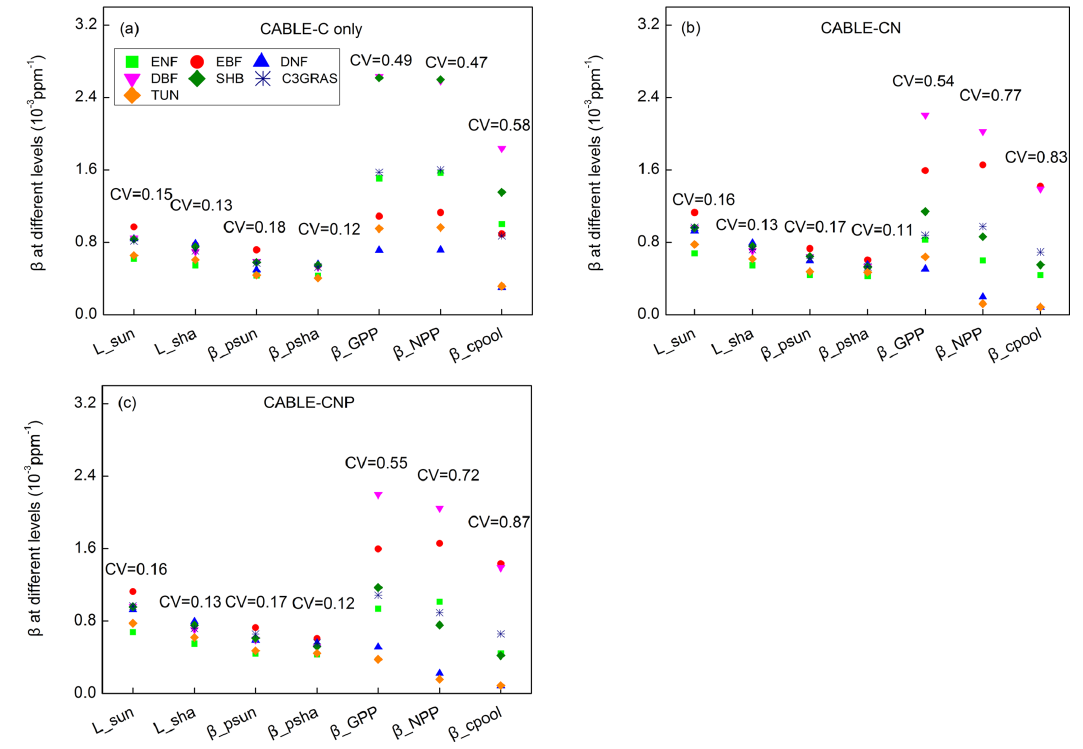
Figure 3. Biome-level β values at different levels at the year 2023 from CABLE-C-only (a) , CABLE-CN (b) , and CABLE-CNP (c) simu- lations. CV means coefficient of variation of biome-level β across C 3 PFTs. β values at biochemical ( L sun and L sha for sunlit and shaded leaves, respectively) and leaf levels ( β p and β p for sunlit and shaded leaves, respectively) are very similar across PFTs, but greatly sun sha diverge at canopy level ( β GPP ) and ecosystem levels ( β NPP and β cpool ) in all simulations. Unlike in C-only simulation, β NPP diverges more than β GPP across different PFTs in nutrient-coupled simulations. Abbreviations and symbols are the same as Fig.